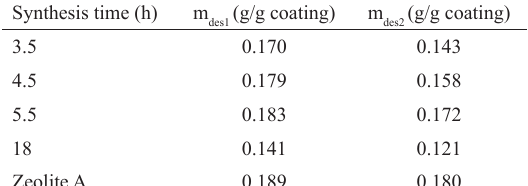
Table 2: Desorption capacities of coatings prepared from composition C at 90 0 C by conventional synthesis and the capacity of primary commercial zeolite A powder. m second TG measurements performed for each sample.